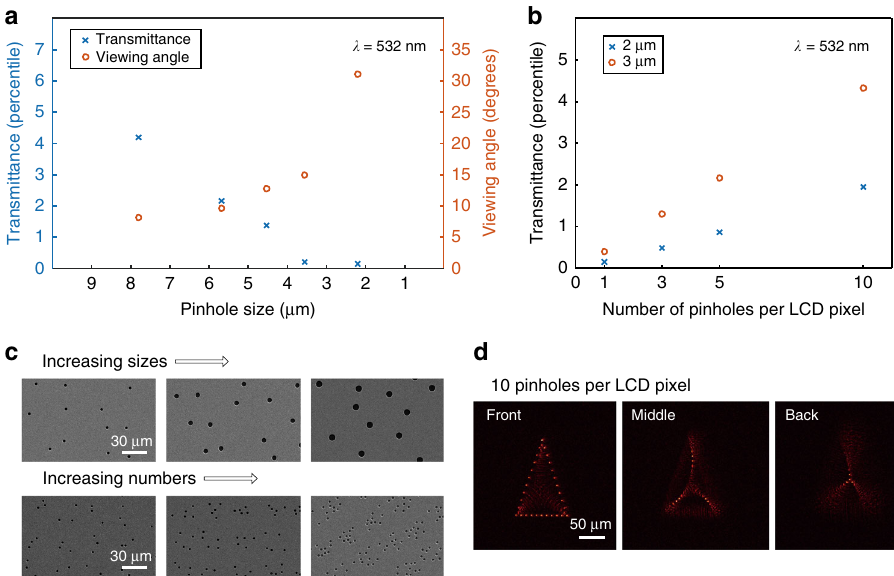
Fig. 5 Varying sizes and numbers of pinholes. Total light transmittance of the photon sieve versus size ( a ) and numbers ( b ) of the pinholes. The number of pinholes is equal to the number of the LCD pixels in a . c Scanning electron microscope images of the photon sieves. d Holographic tetrahedron projected by using the photon sieve having 10 pinholes per LCD pixel